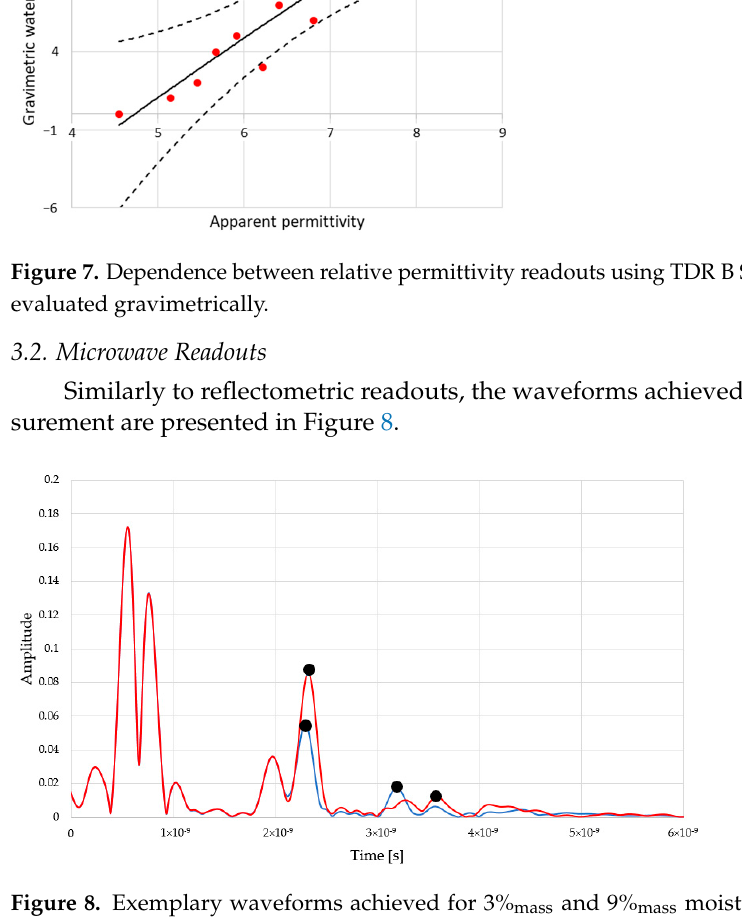
Figure 8. Exemplary waveforms achieved for 3% mass and 9% mass moist material with the use of mi- crowave reflectance sensor. microwave reflectance